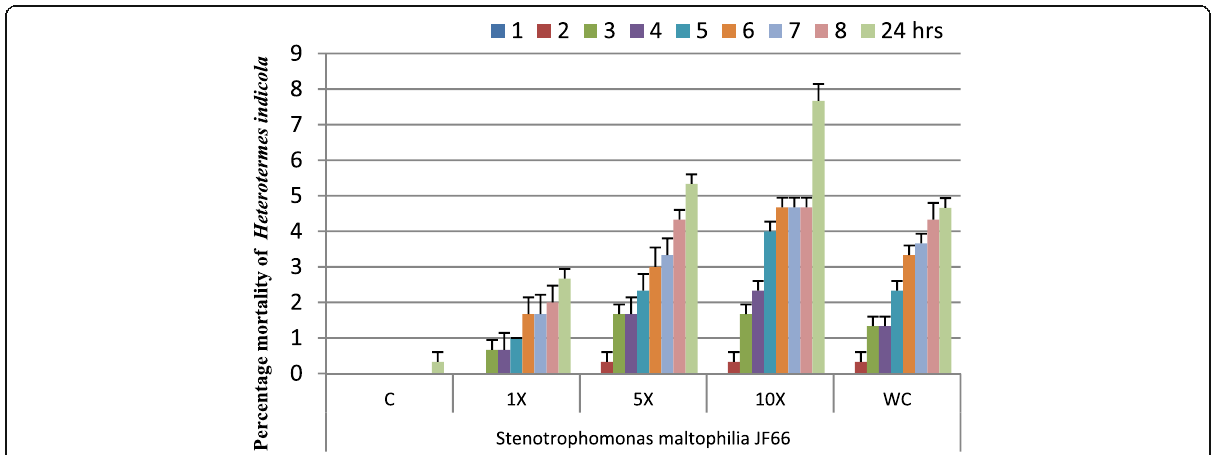
Fig. 10 Percentage mortality of Heterotermes indicola exposed to the cultures (WC) and cell-free culture fluids of varying strength of Stenotrophomonas maltophilia